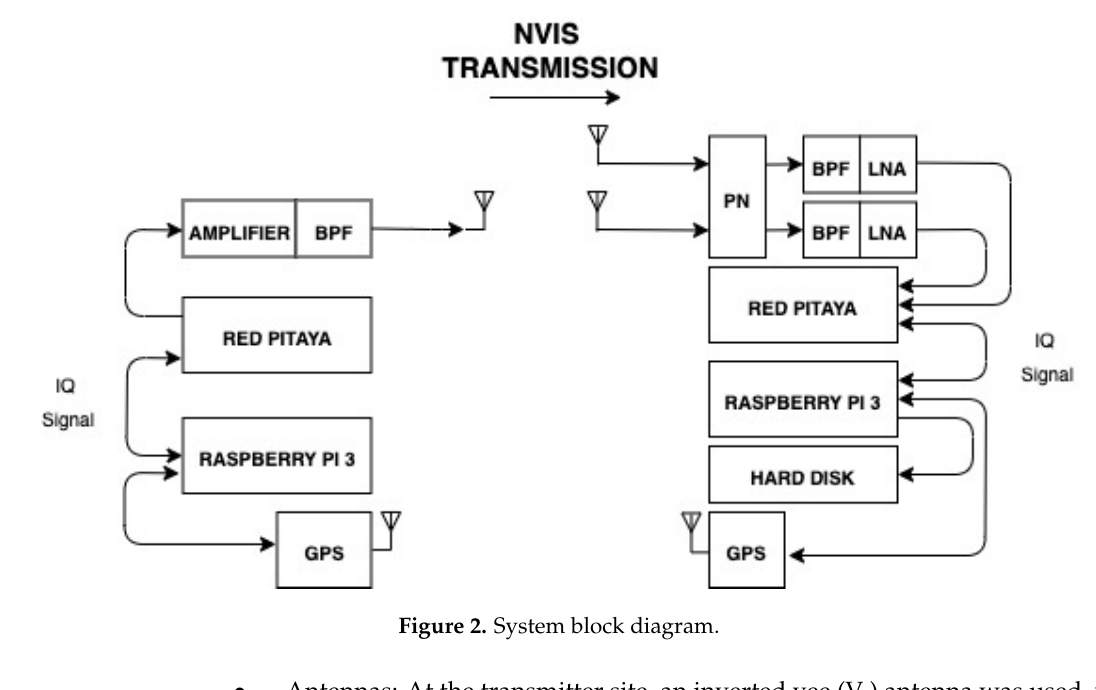
Figure 2. System block diagram.